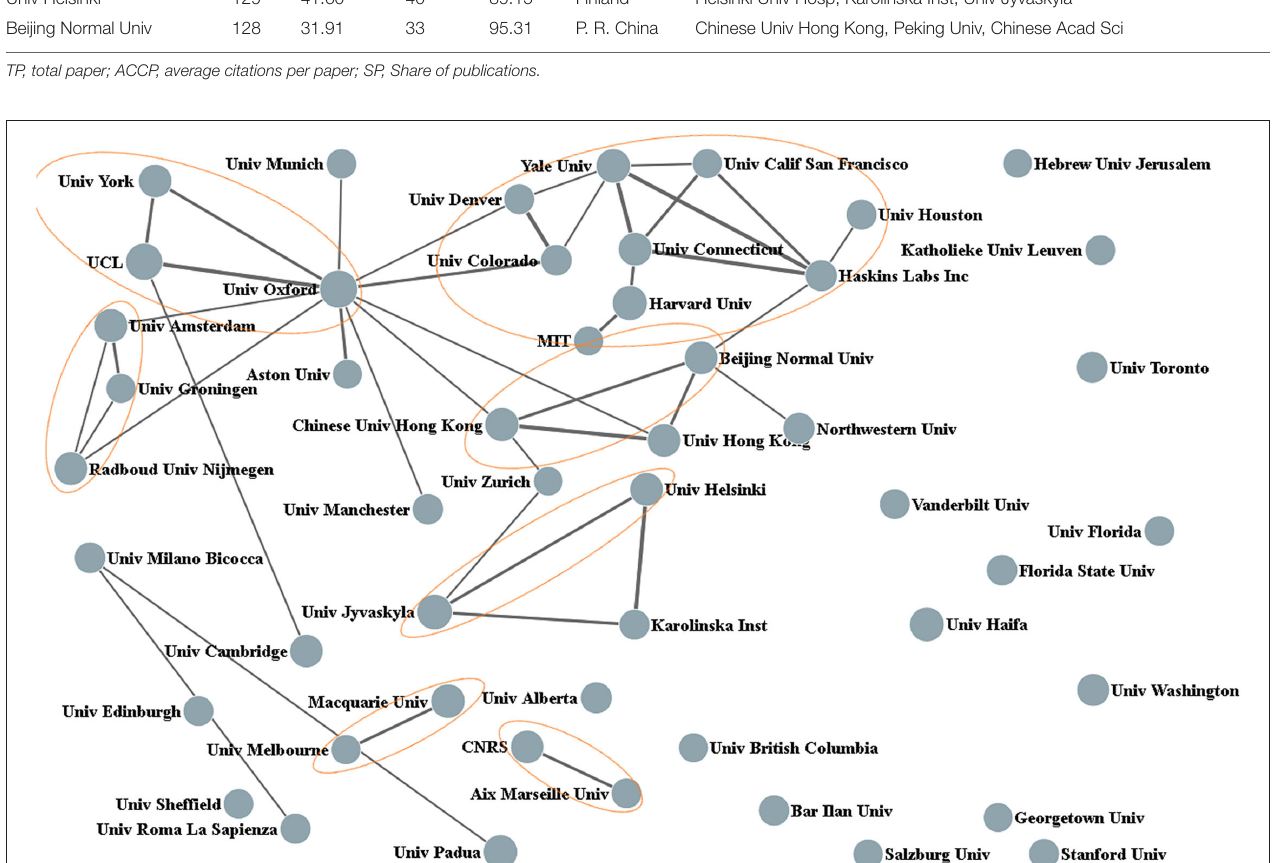
Journal of Learning Disabilities and Annals of Dyslexia than other countries. These suggested that the United Kingdom and United States of America researchers prefer to publish in journals hosted by their